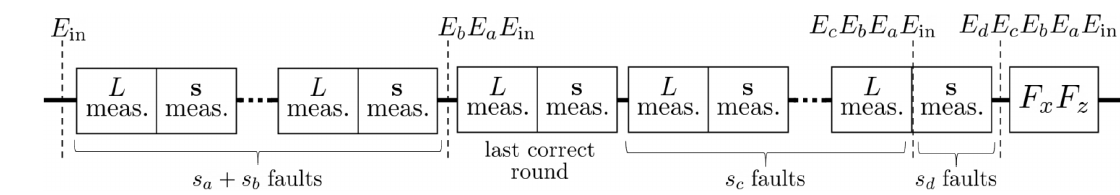
FIG. 15. Fault-tolerant measurement protocol for a capped color